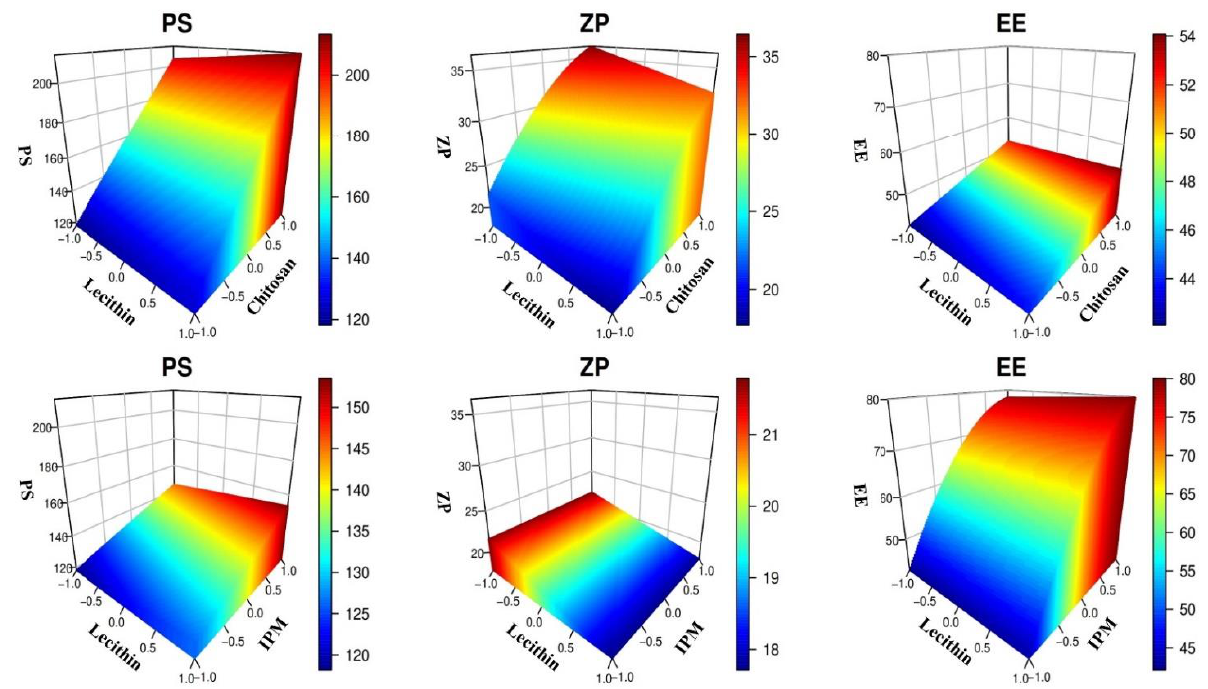
Figure 1. 3D response surface plots for the influences of LC amount, CTS amount, and IPM concentrations on BER-LC-CTS-NPs PS, ZP, and EE%.